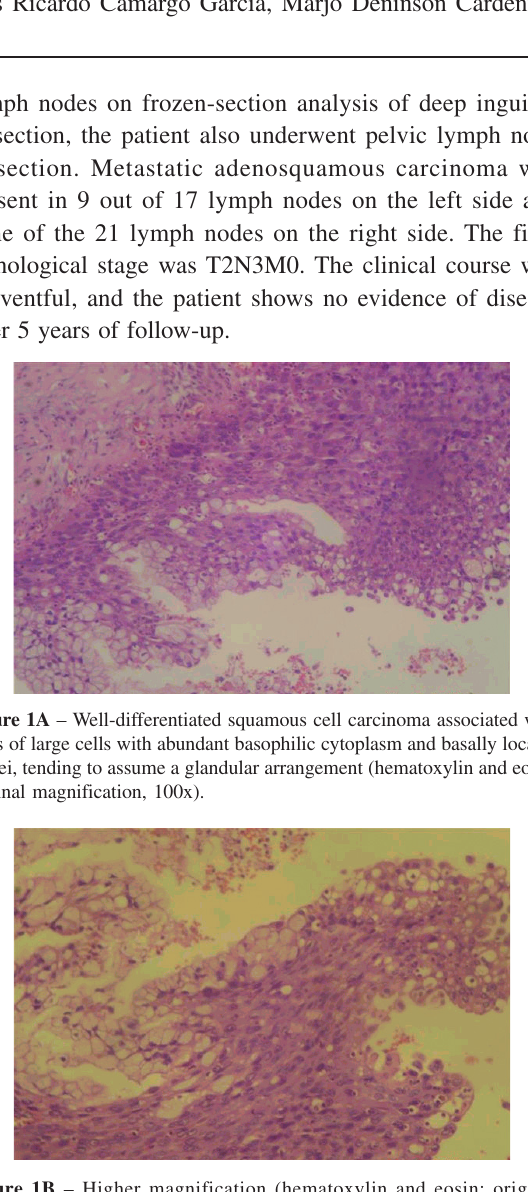
Figure 1B – Higher magnification (hematoxylin and eosin; original magnification,